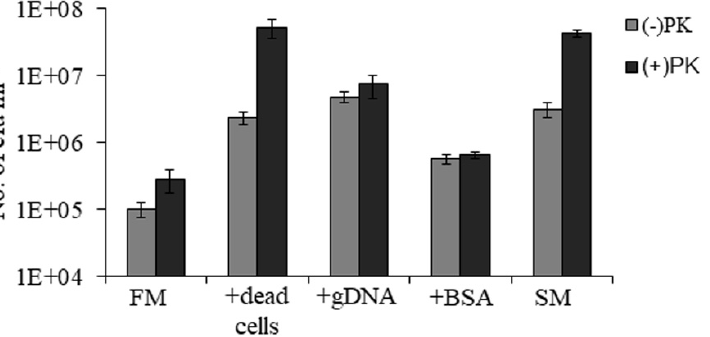
Figure 5. Growth-promoting components of spent ASW media. The growth of culturable cells was checked in ASW media (FM), ASW media with 10 7 cells of dead bacteria (+dead cells), ASW media with 10 µg mL − 1 genomic DNA (+gDNA), ASW media with 100 of µg mL − 1 BSA (+BSA) and spent ASW media (SM). The cell count was determined after 32 h of incubation and represented as ( − ) PK. The samples in the presence of proteinase K are represented as (+) PK.